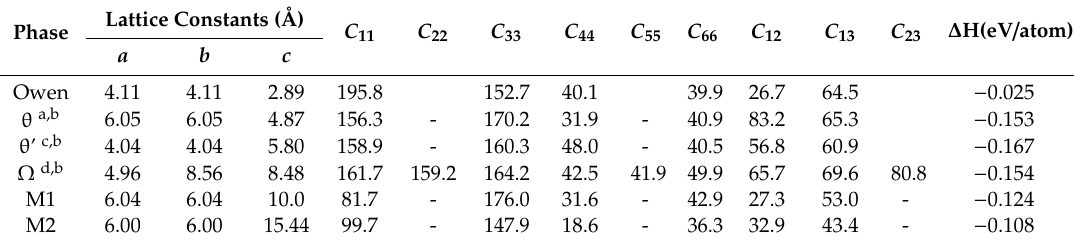
Table 2. The cell parameters, elastic constants, and the enthalpy of formation of Al 2 Cu (1924) θ , θ ’, Ω , M1,